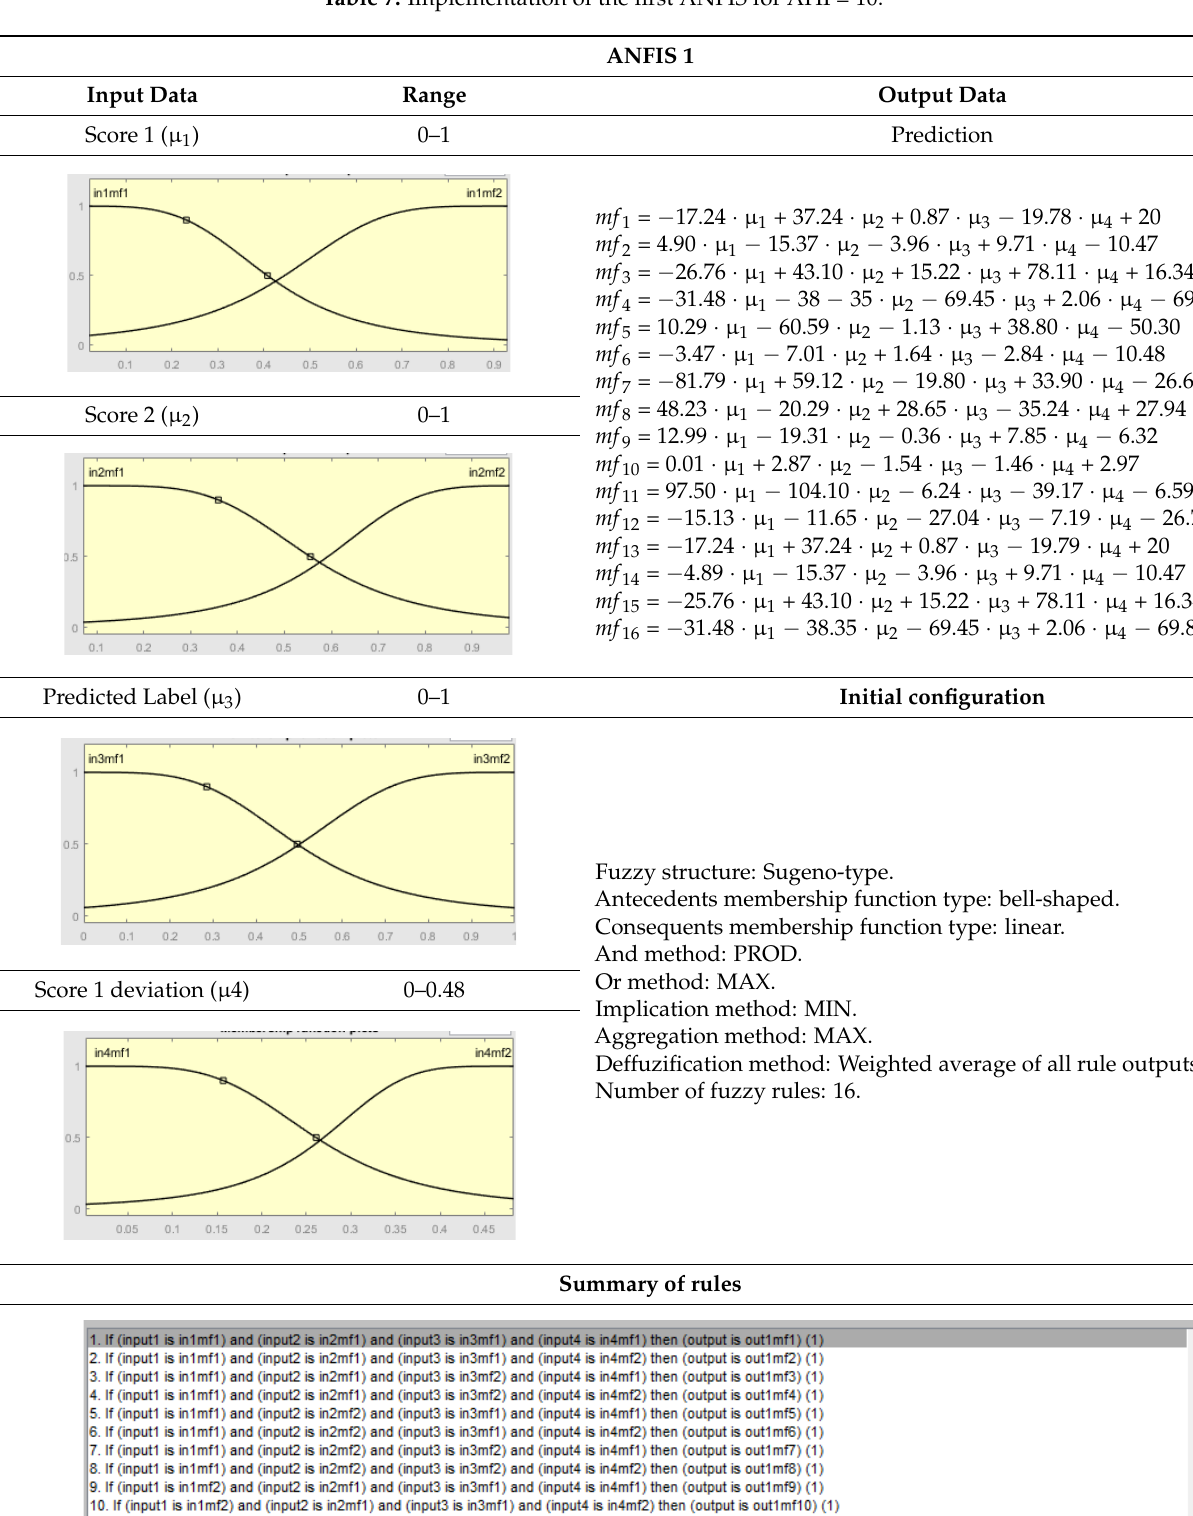
Table 7. Implementation of the first ANFIS for AHI =